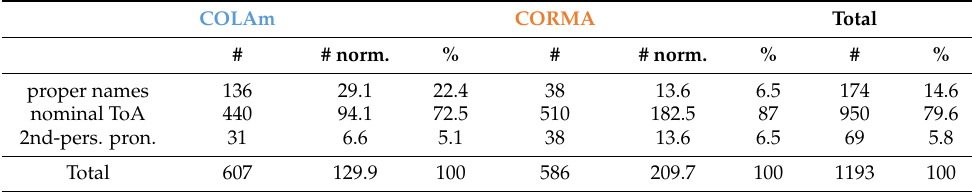
Table 6. Distribution of general categories of vocatives per corpus. COLAm CORMA Total # #